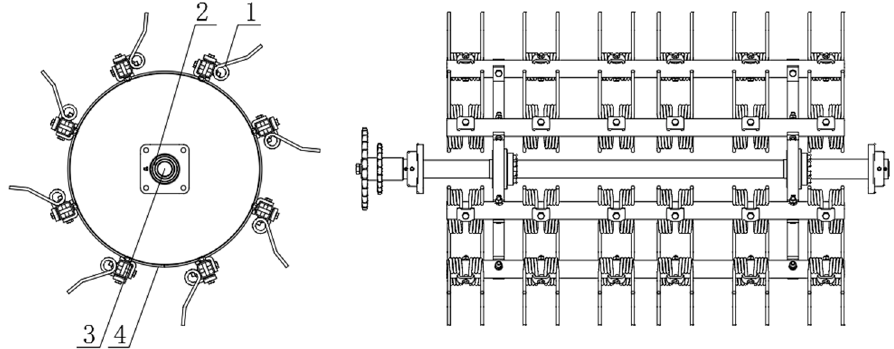
Figure 3. Overall structure of peanut harvester. 1: Spring teeth. 2: Adjustment plate. 3: Intermediate shaft. 4: Harvesting roller.